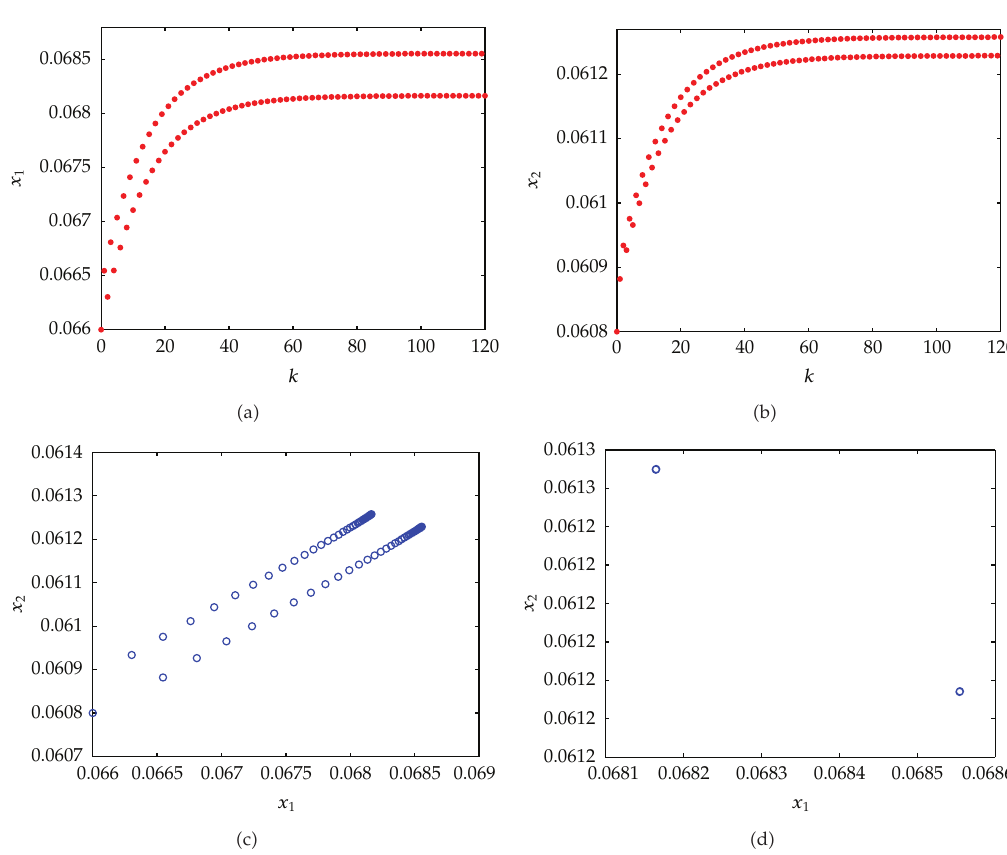
Figure 2: Dynamic behaviors of system (cid:4) 4.1 (cid:7) with x 1 (cid:4) − 1 (cid:7) (cid:9) 0 . 02, x 1 (cid:4) 0 (cid:7) (cid:9) 0 . 0660, x 2 (cid:4) − 1 (cid:7) (cid:9) 0 . 03, and x 2 (cid:4) 0 (cid:7) (cid:9) 0 . 0608. (cid:4) a (cid:7) Time series of x 1 . (cid:4) b (cid:7) Time series of x 2 . (cid:4) c (cid:7) Phase portrait of x 1 and x 2 with k over (cid:5) 0 , 120 (cid:6) . (cid:4) d (cid:7) Phase portrait of x 1 and x 2 with k over (cid:5) 110 , 120 (cid:6)